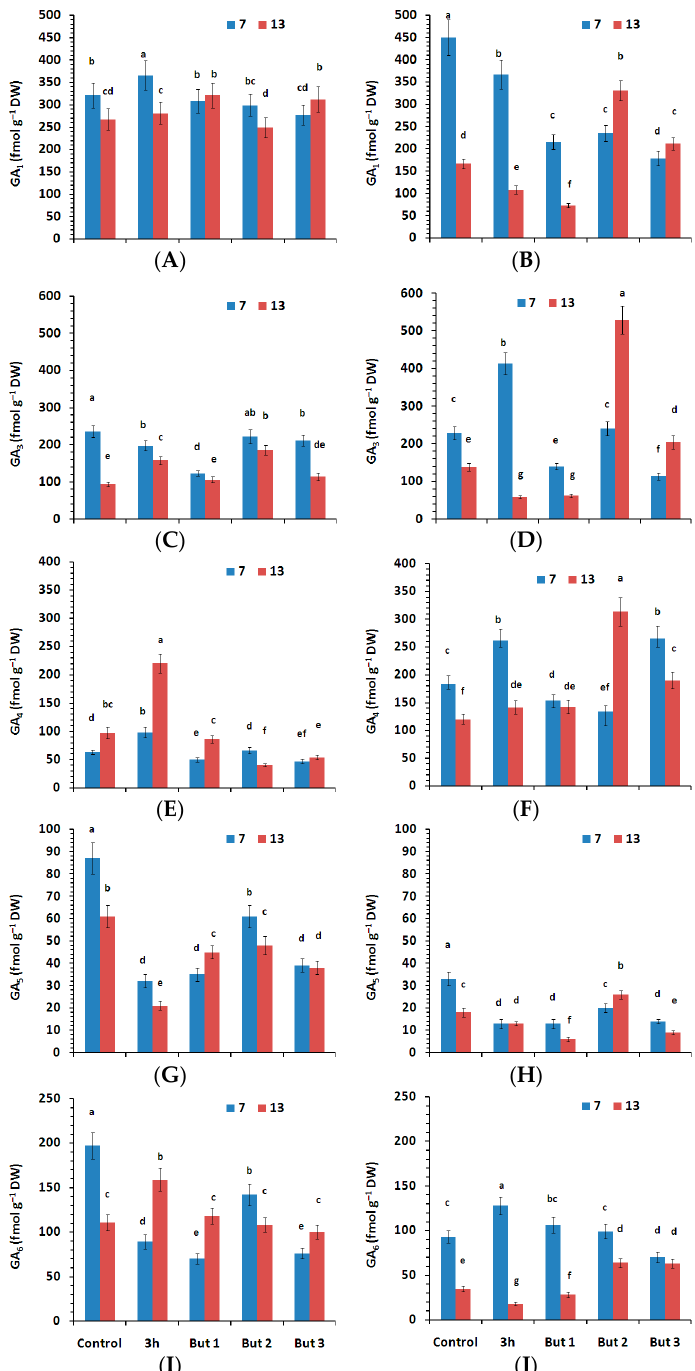
Figure 6. Content of active gibberellins (GA 1 , GA 3 , GA 4 , GA 5 , GA 6 ) measured in the seeds of two L. angustifolius cultivars (Lazur—( A , C , E , G , I ); Sethes Fruehe Rote—( B , D , F , H , J )) germinated at 7 °C or 13 °C in water (control), butenolide or hydroprimed in water for 3 h at 20 °C. But 1, But 2, But 3: 10 − 6 M, 10 − 5 M, 10 − 4 M butenolide concentrations. Different letters over error bars ( ± SE; n = 3) indicate significant differences (Duncan’s multiple range test, p <